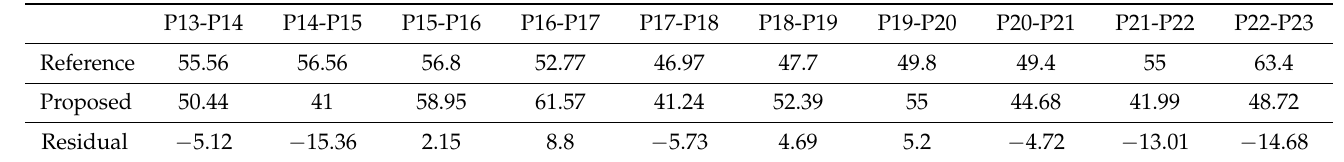
Table 3. The estimated residuals of the ridge height ( µ m) between the proposed method and reference data from point 13 to point 23.